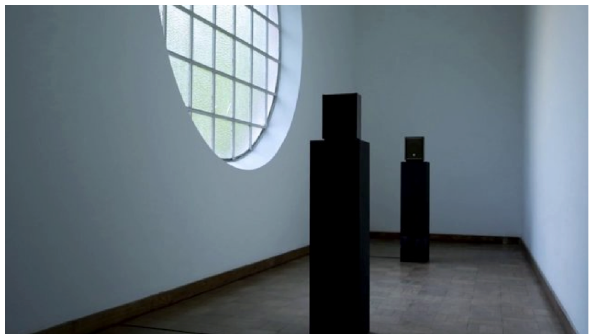
Figure 6 | Re-interpretation sound